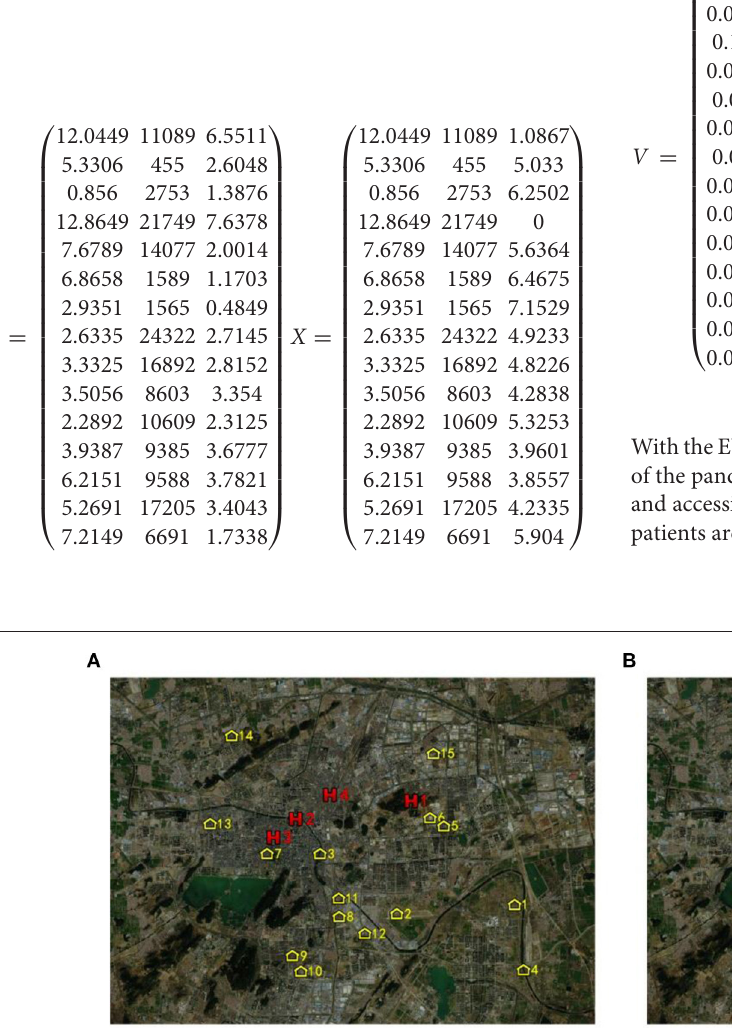
Frontiers in Public Health |